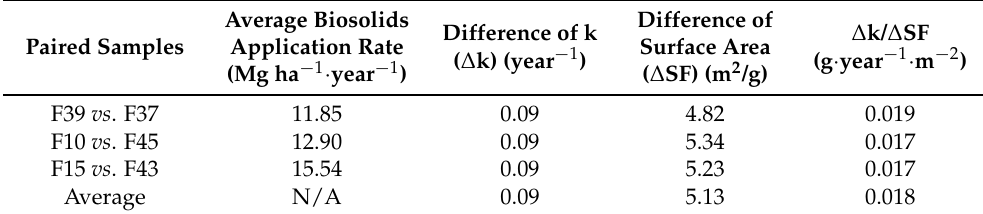
Table 3. Comparison of changes in biosolids degradation rate and mineral soil surface area for paired soils (same biosolids application rate, but different soil texture).